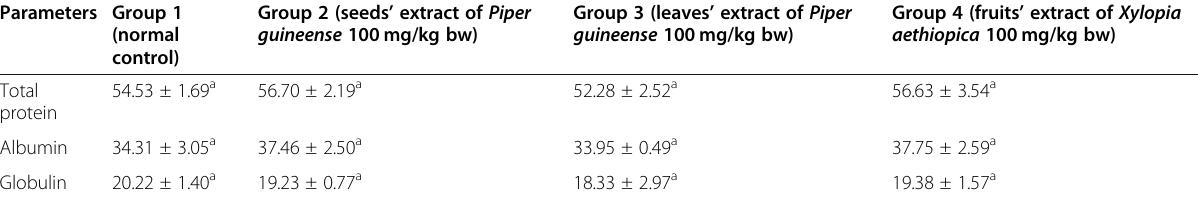
Table 2 Concentrations of proteins (g/L) in rats administered ethanolic extracts of fruits of Xylopia aethiopica and seeds and leaves of Piper guineense